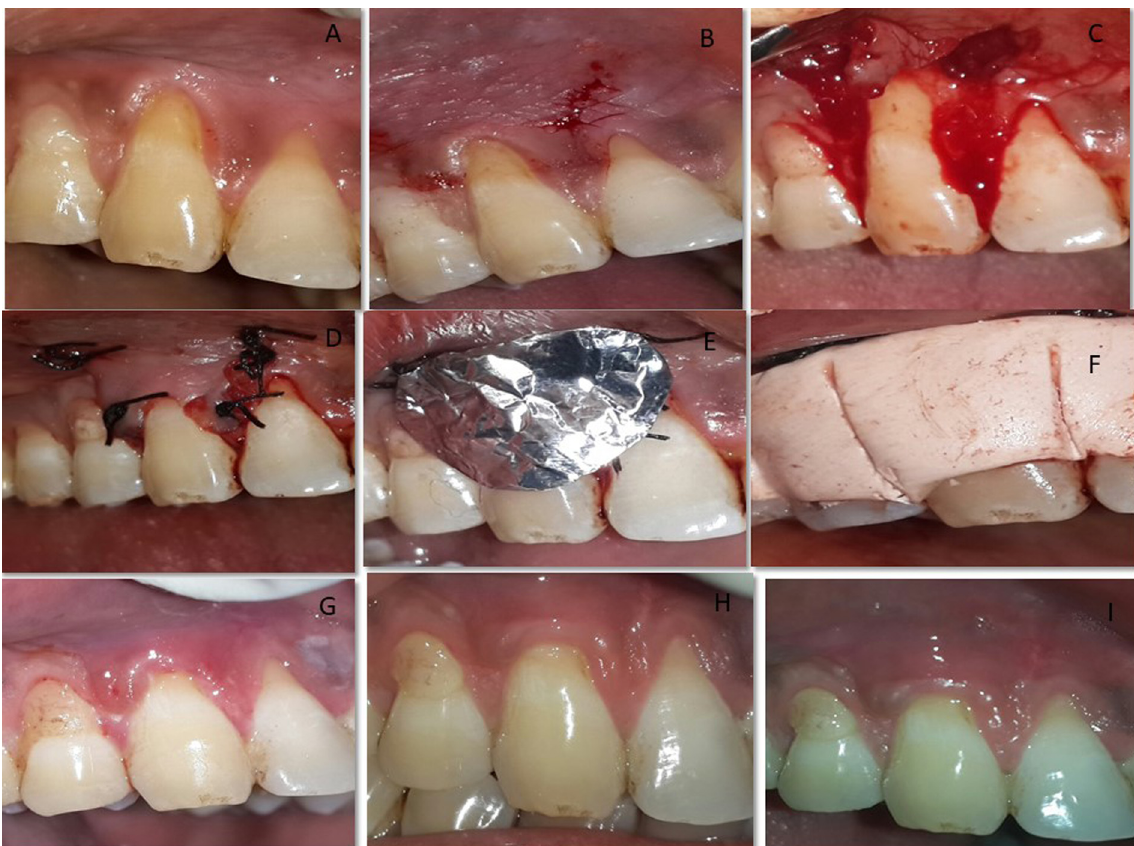
Fig. 1. Pre-surgical, surgical and post-surgical recipient site treated by CAF for Control Group, Case 1. (A) Preoperative gingival recession defect with 13. (B) Horizontal and vertical incisions performed. (C) Split-full (cid:1) split thickness fl ap re fl ected. (D) CAF sutured. (E) Tin foil placed. (F) Periodontal pack placed. (G) Post-operative view at 15 days. (H) Post-operative view at 60 days. (I) Post-operative view at 90